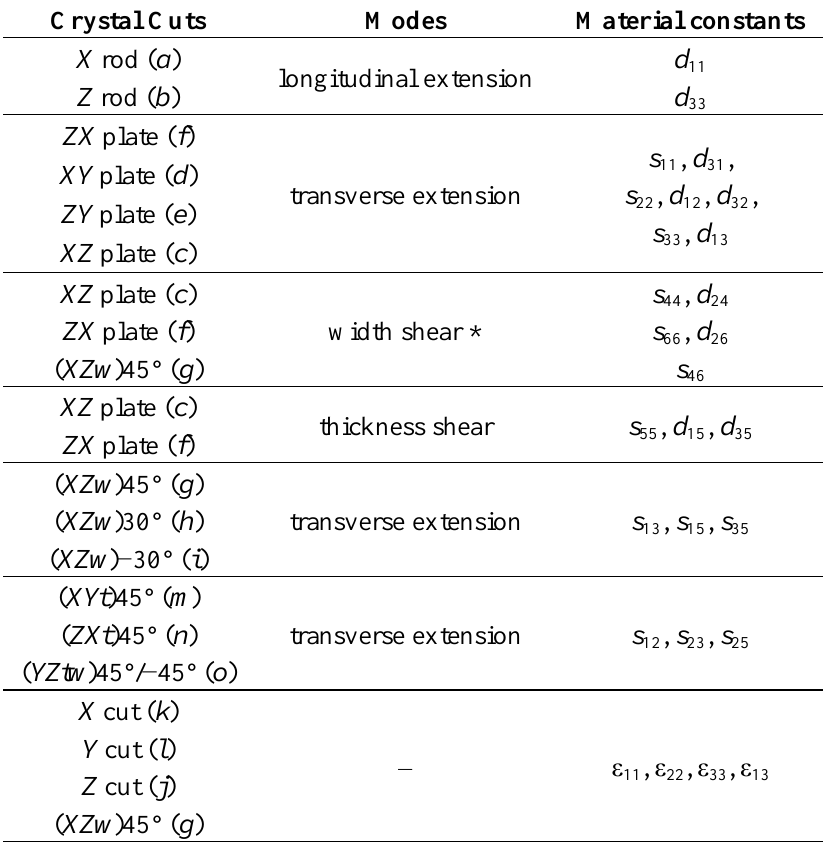
Table 3. A summary of different crystal cuts for material constants’ determination, reprinted with permission from [57]. Copyright 2014